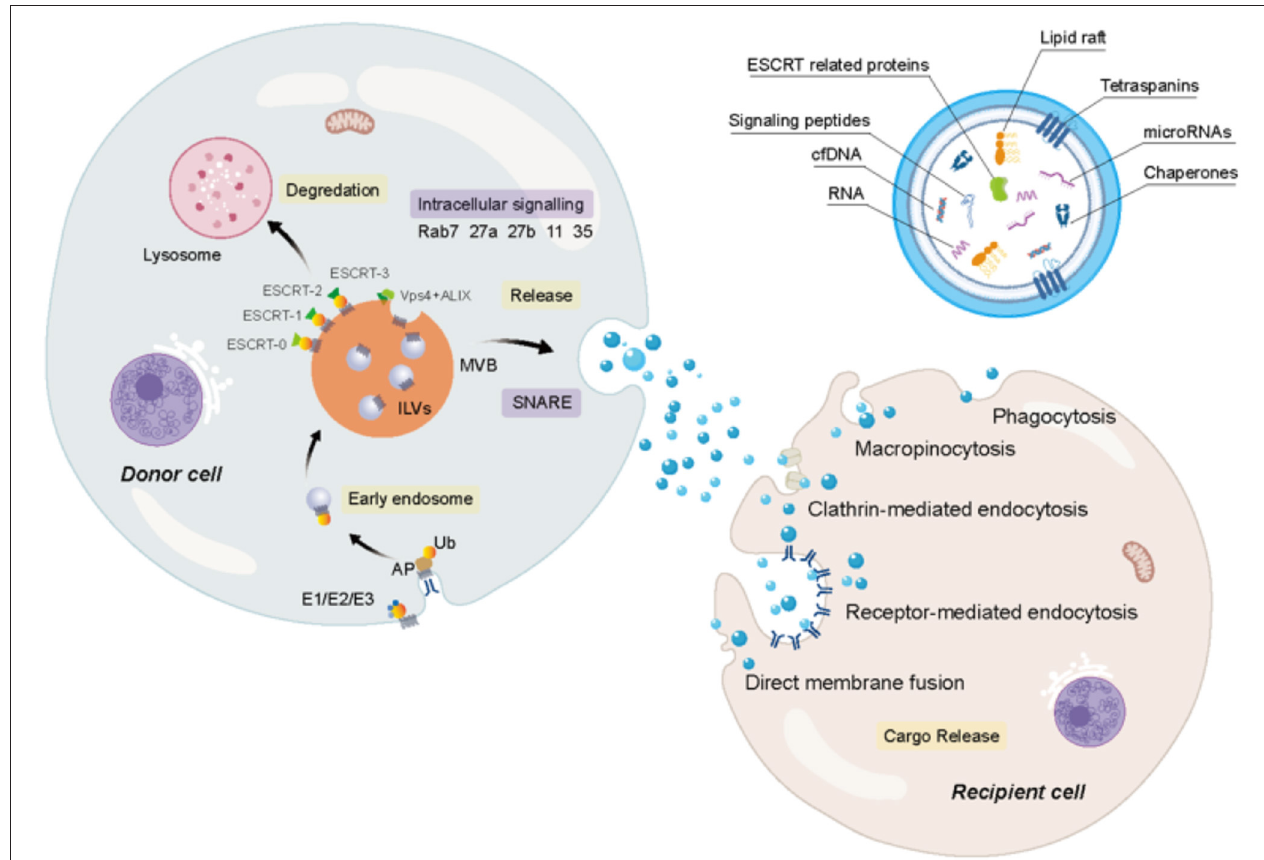
FIGURE 1 | The biogenesis and secretion of extracellular vesicles (EVs) and the uptake of receptor cells. Firstly, after the fusion of particular cargoes with cell membranes, plasma membrane involution induces the creation of early endosomes. And then during the maturation of the endosome, the late endosomes germinate intraluminal vesicles (ILVs), forming multivesicular bodies (MVBs), which cannot only fuse with lysosomes for degradation, but also further fuse with plasma membrane to release exosomes. It is undeniable that the endosomal sorting complex required for the transport (ESCRT) complexes (ESCRT0, ESCRT-I, ESCRT-II, and ESCRT-III) are vital for MVB biogenesis. Several proteins, such as apoptosis-linked gene-2 (ALG-2) interacting protein X (ALIX), ATPase, and vacuolar protein sorting-associated protein (VPS4), also involve in regulating biogenesis, soluble N-ethylmaleimide-sensitive factor attachment protein receptors (SNAREs) participate in the fusion of MVBs with the plasma membrane. Members of the Rab family jointly regulate the secretion of exosomes, such as Rab-7, Rab-35, Rab-11, Rab-27a, and Rab-27b. The exosome contains a wide variety of cargoes. The uptake of exosomes can be inferred through several